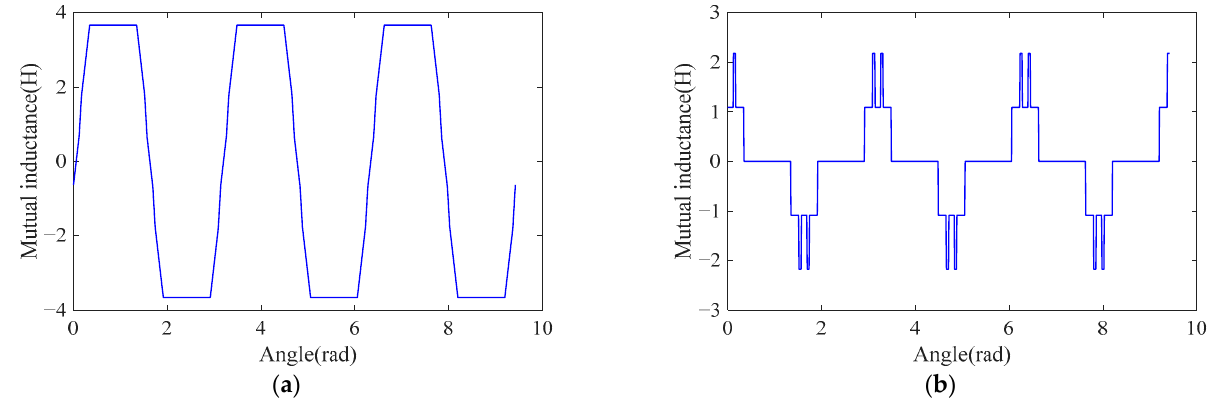
Figure 7. Stator–rotor mutual inductance and its differential curve under the condition of uniform air